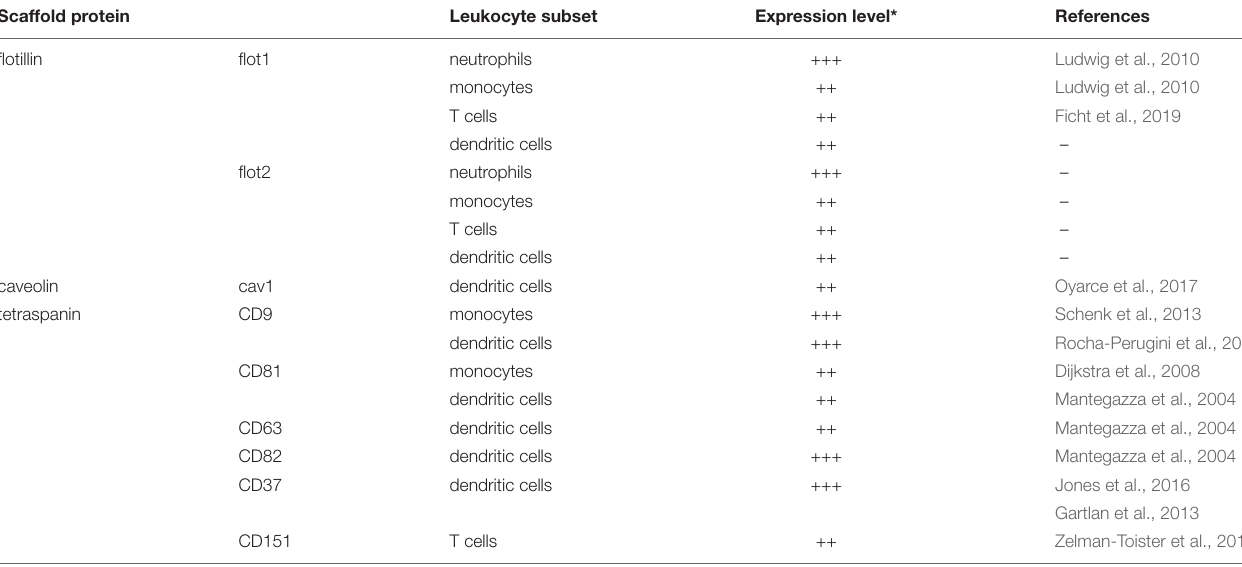
TABLE 1 | Expression level of scaffold proteins in various leukocyte subsets. Scaffold